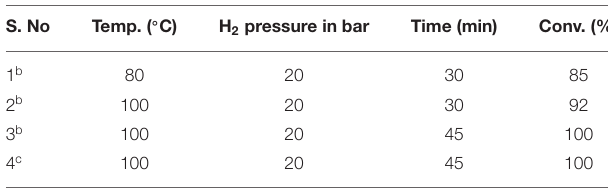
TABLE 2 | Optimization of reaction condition for glucose and mannose hydrogenation to sorbitol and mannitol using HRO/Na- β pre-catalyst a